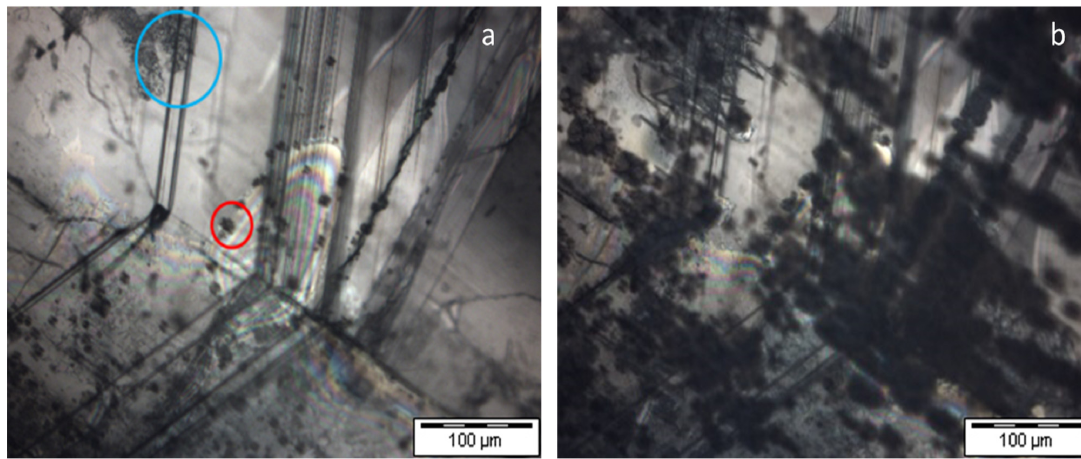
Figure 3. Gypsum crystal at ( a ) 135 °C, and ( b ) 142 °C.